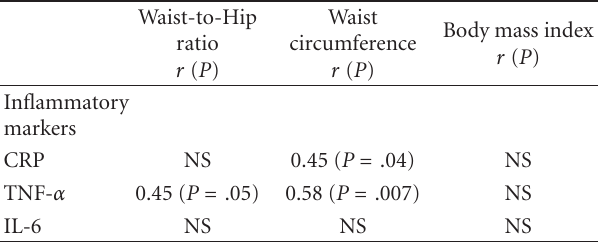
Table 2: Correlations between systemic inflammatory markers and anthropomorphic